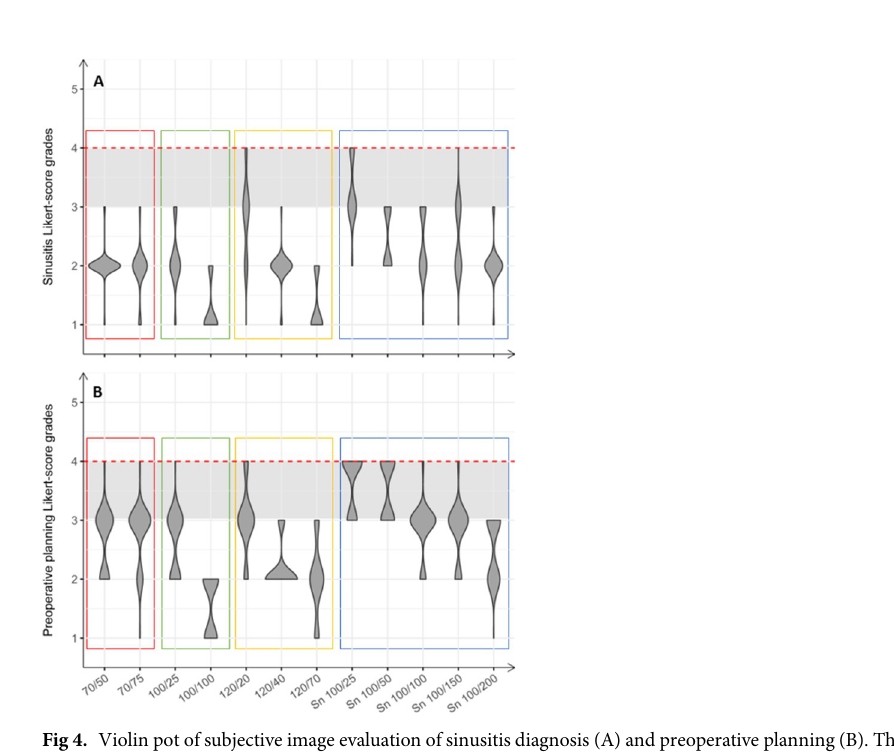
Fig 4. Violin pot of subjective image evaluation of sinusitis diagnosis (A) and preoperative planning (B). The horizontal red dotted line showed the Likert grade above which the diagnostic image quality is insufficient for clinical use. Grey horizontal box shows area in which image quality is impaired. Colored rectangles refer to the different tube voltages examined: Red = 70 kV, green 100 kV, yellow = 120 kV and blue = Sn 100 kV.